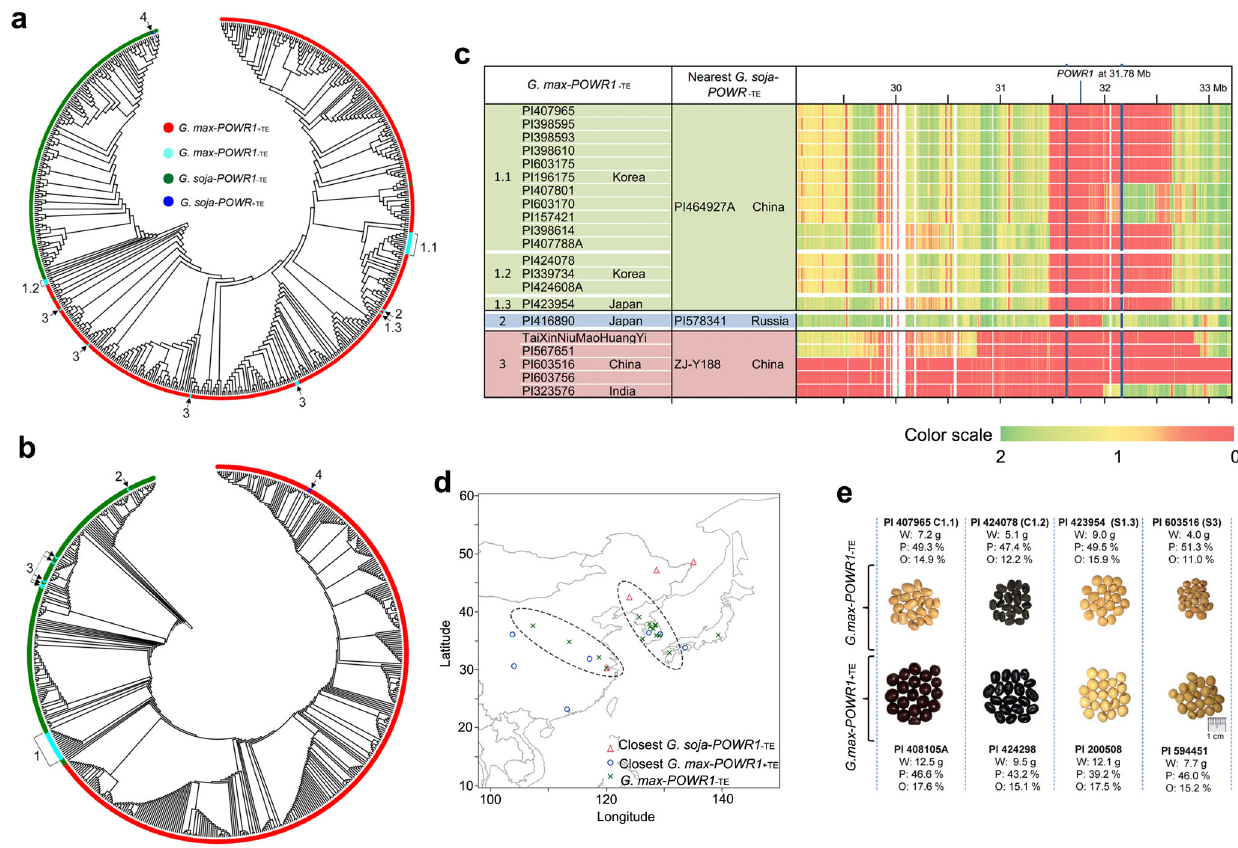
Fig. 5 Dynamic interspeci fi c transfer of POWR1 . a , b A global ( a ) and a local ( b ) phylogenetic tree constructed from 548 G. soja and G. max accessions using genome-wide SoySNP50K SNPs and 1000 SNPs spanning the 154-kb region containing POWR1 , respectively. Labels (1, 2, 3, 4) in the local tree indicate four clusters of accessions containing unusual genotypes [ G. max-POWR1 − TE (1,2,3), G. soja-POWR1 + TE (4)]. The labels in the global tree correspond to the labels in the local tree. c Pairwise nucleotide distance analyses of each G. max-POWR1 − TE accession with its closest G. soja-POWR1 − TE accession across the 4-Mb region. The clusters of these accessions and the countries of their origins are shown. The pairwise distance is indicated by a color scale from red (close) to green (distant). The domestication region identi fi ed based on Tajima ’ s D (see Fig. 4c) is delineated by blue lines. The physical location of POWR1 is marked on top. d Interspeci fi c allele transfer. Geographic origins of G. max-POWR1 − TE accessions and their closest G. soja- POWR1 G. max-POWR1 − TE and + TE accessions are shown. Dotted circles depict the geographic regions in China, North and South Korea, and Japan where the interspeci fi c allele transfer might occur. Latitude and longitude are shown. e G. max - POWR1 − TE accessions have smaller seeds than their closest related G. max - POWR1 G. max accessions from clusters 1.1 (C1.1) and 1.2 (C1.2), 1.3 (S1.3), and 3 (S3) that carry + TE accessions. The top panel shows representative POWR1 − G. max-POWR1 + TE . The bottom row shows their closest related TE accessions. PI number, 100-seed weight (W), seed protein content (P), and seed oil content (O) are provided for each accession. Source data are provided as a Source Data fi